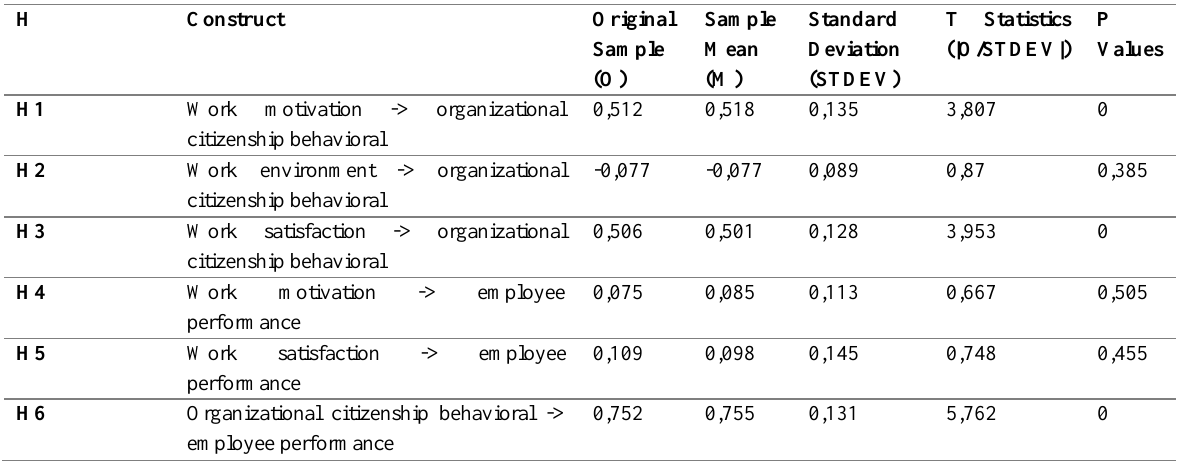
Table 5: Summary of The Structural Model H